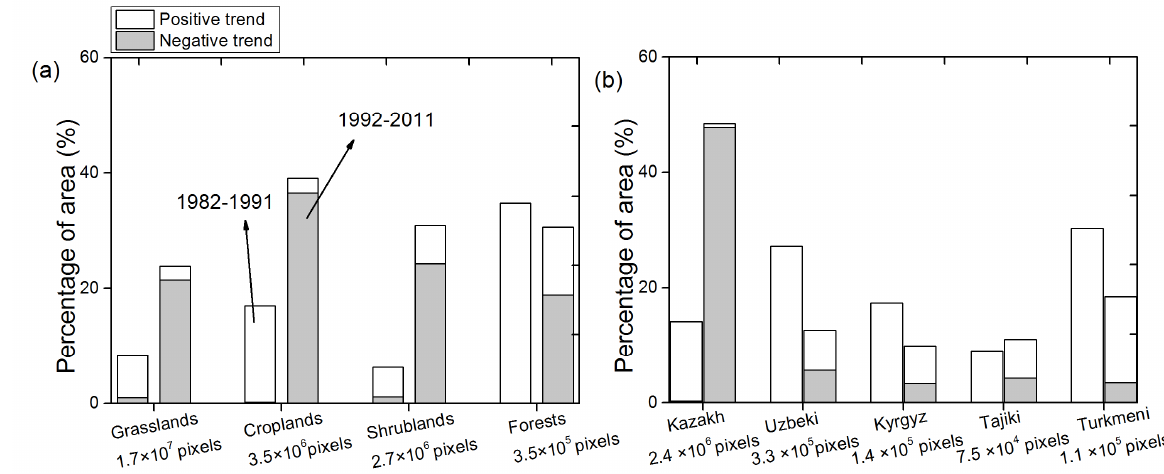
Figure 5. Percentage of the area with significantly positive (white) and negative trends (gray) ( p -value < 0.05) during 1982–1991 (left columns) and 1992–2011 (right columns) for the ( a ) dominant land cover types (with the number of pixels below) and ( b ) croplands in Kazakhstan, Kyrgyzstan, Tajikistan, Turkmenistan, and